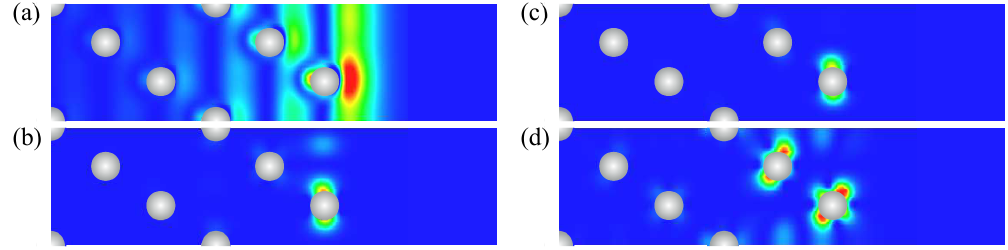
Figure 2. Charge density distribution of (a) Γ 1 , (b) Γ 2 , (c) M 3 , (d) K 4 surface states on clean Pt(111) surface obtained from the WSOC calculation. The Pt atomic positions are shown by grey